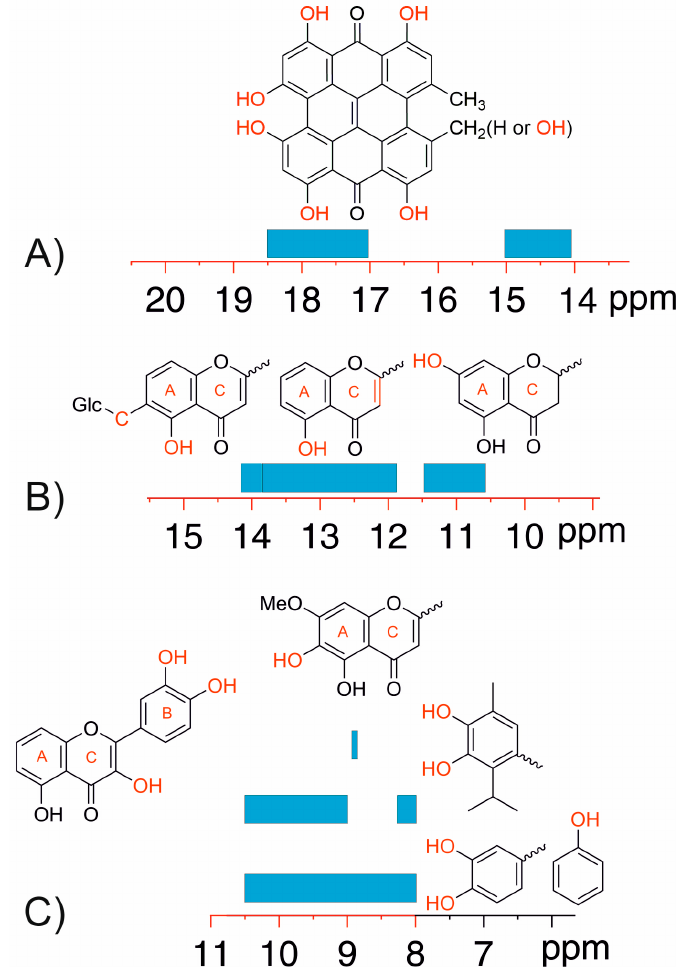
Figure 4. Classification of the chemical shifts of the –OH groups in DMSO- d 6 on the basis of the structure of the molecule and the nature of the substituent in the rings. ( A – C ) are the regions of 14–20 ppm, 10–15 ppm, and 8–10.5 ppm, respectively. Reprinted, with permission, from [67]. Copyright 2014, by MDPI.